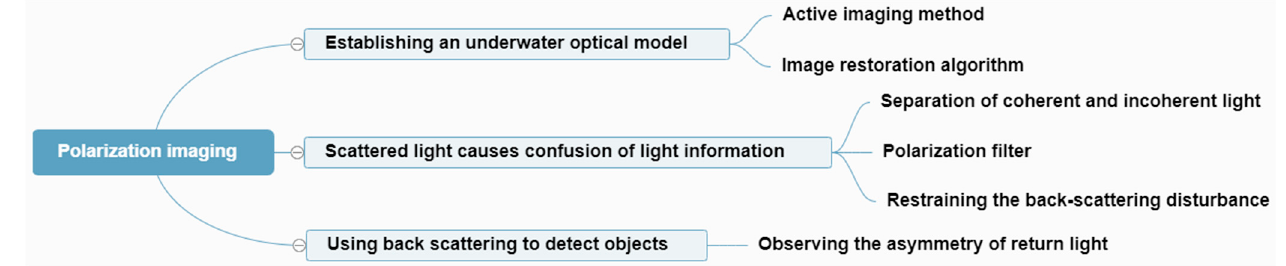
Figure 5. An overview of underwater data processing methods based on polarization